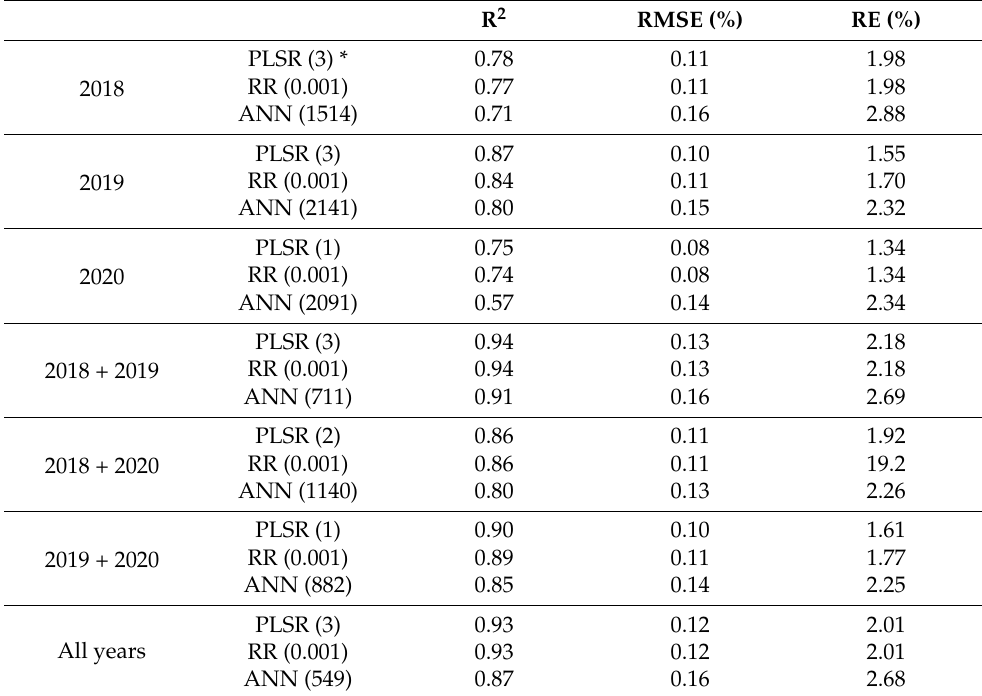
Table 6. Performance of PLSR, RR, and ANN models in the prediction of rice-protein content in single- and multiple-year